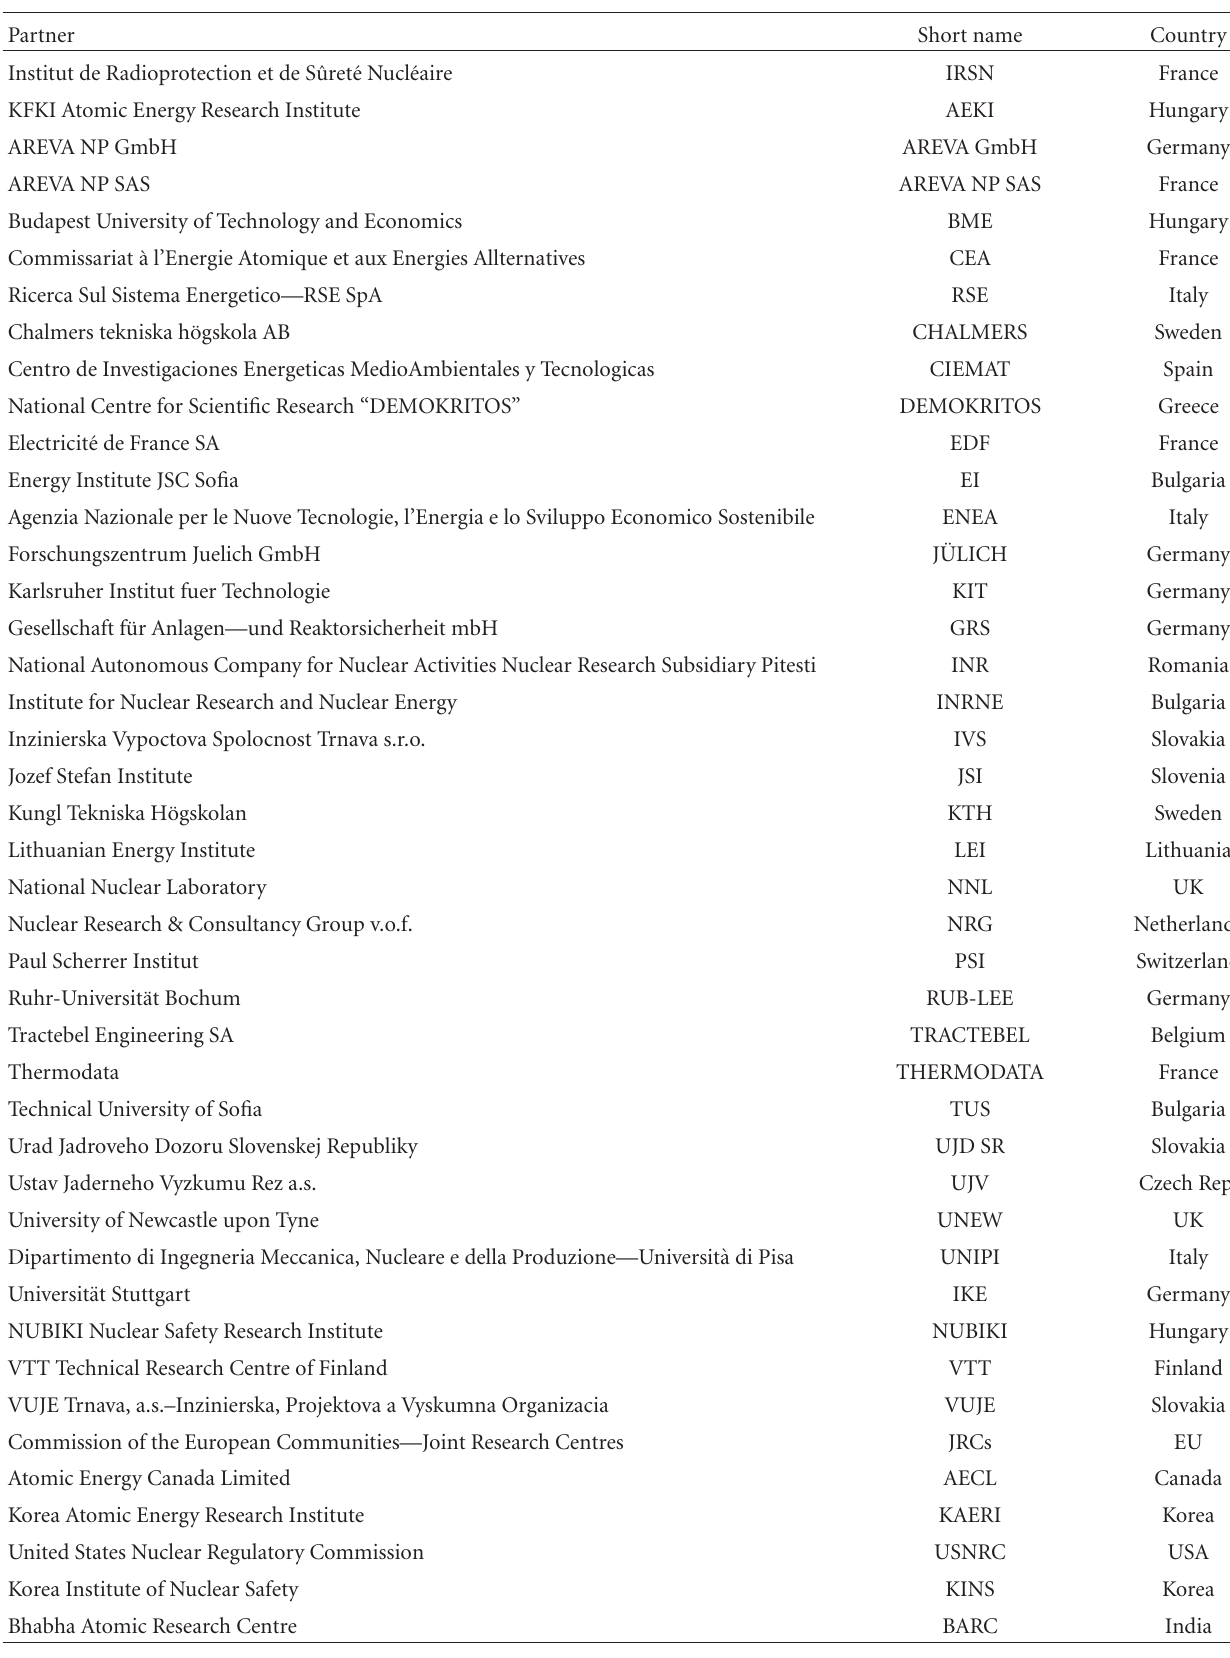
Table 1: List of SARENT